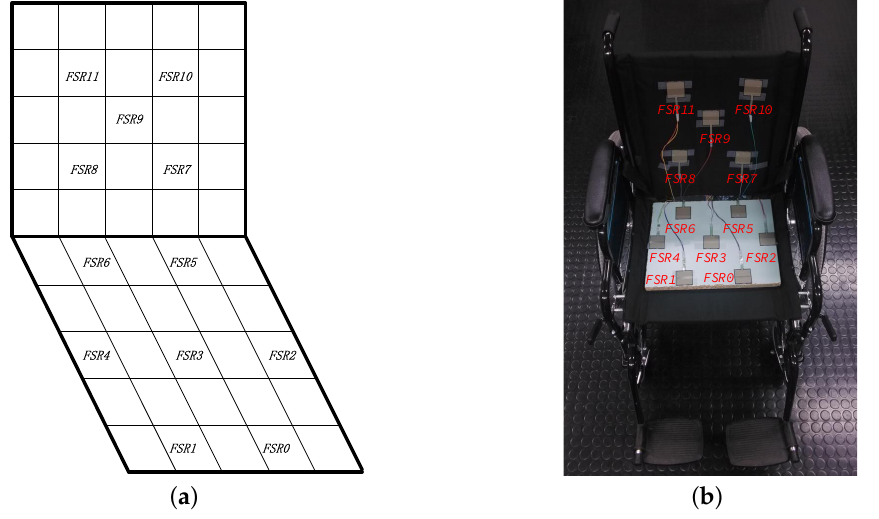
Figure 3. Sensor deployment: ( a ) schematic diagram of the sensor deployment; ( b ) sensors deployed on the real wheelchair.